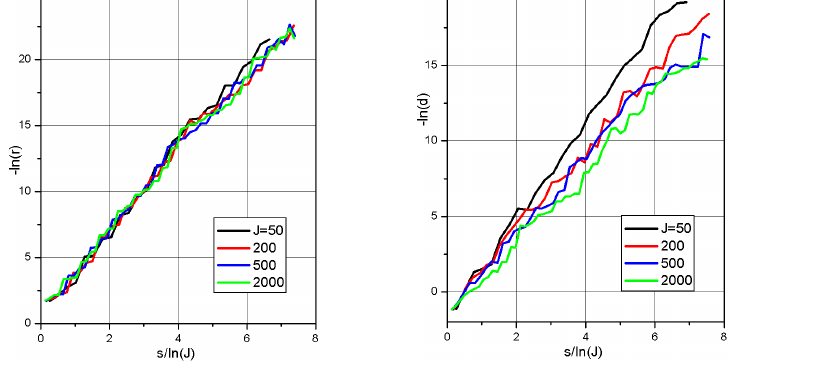
Figure 10. 5-solver, 5-scheme, Neumann for circle.